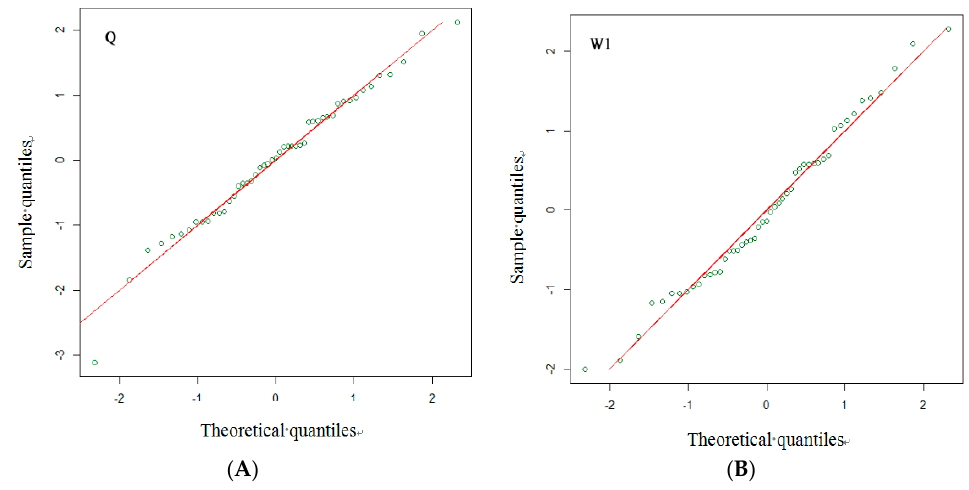
Figure 5. QQ plot of the residuals of non-stationary time-varying model with GAMLSS implementation ( Q in A , W 1 in B ).